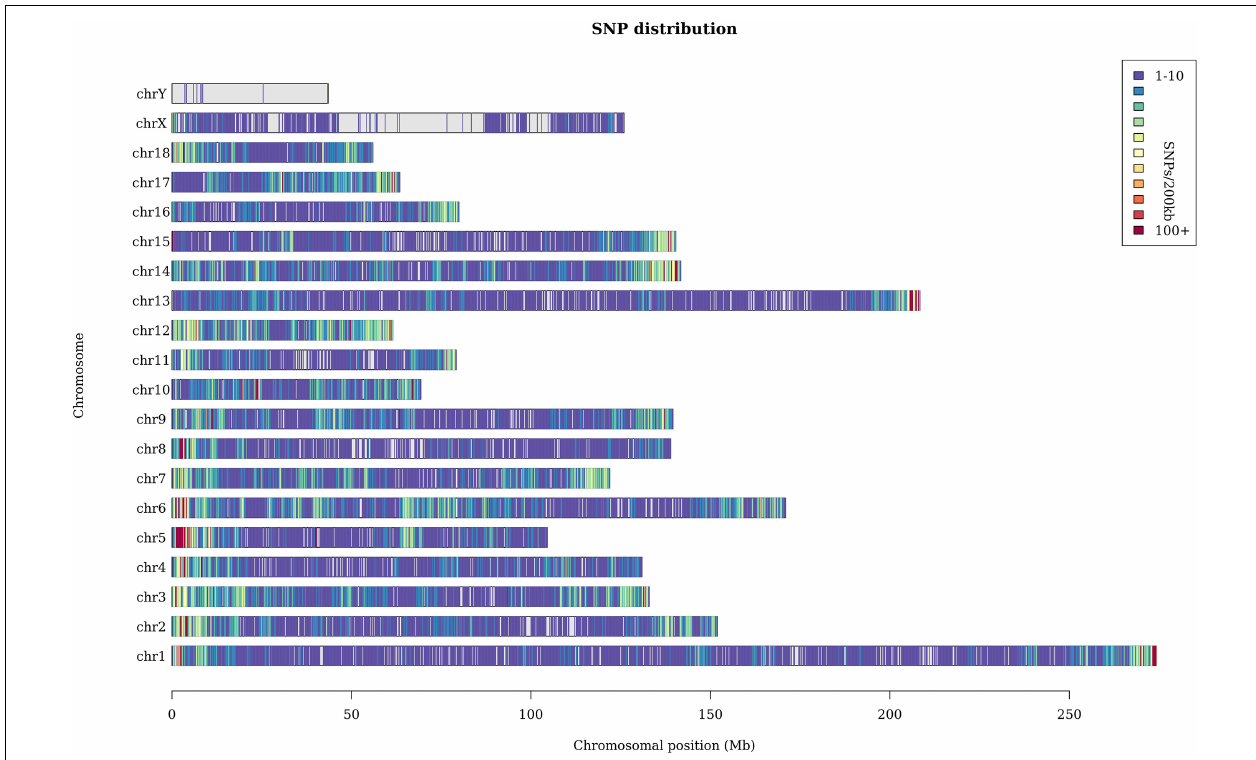
FIGURE 1 | Distribution of the sequenced SNPs on all chromosomes. The y -axis represents chromosomes, and the x -axis represents the corresponding chromosomal position (Mb). Different colors of each 200-kb genome block denote the number of SNPs.